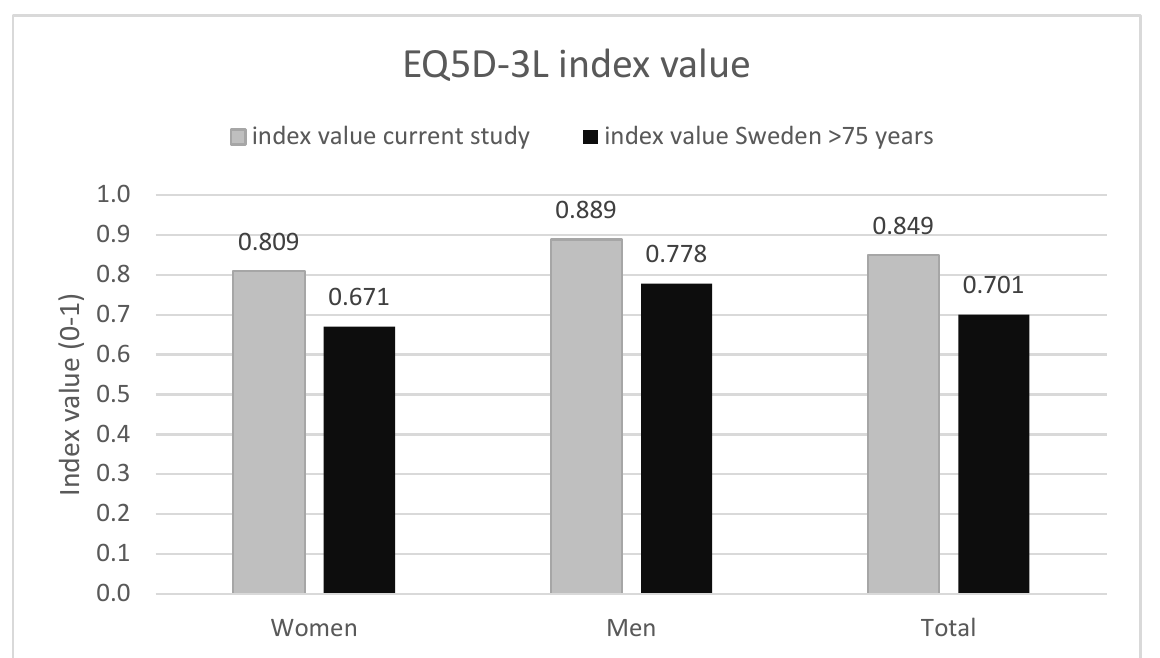
Figure 2. Index value from EQ5D-3L from this study and for an average Swedish population aged 75 and above [18]. The results are displayed in total and separated for men and women.